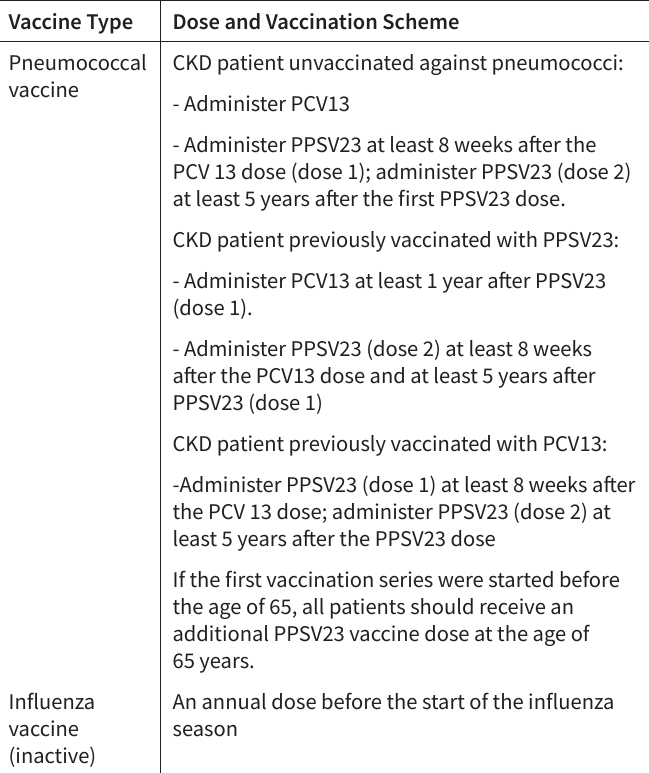
Table 1. The Recommended Pneumococcal and Influenza Vaccination Scheme in Adults With CKD Vaccine Type Dose and Vaccination Scheme Pneumococcal